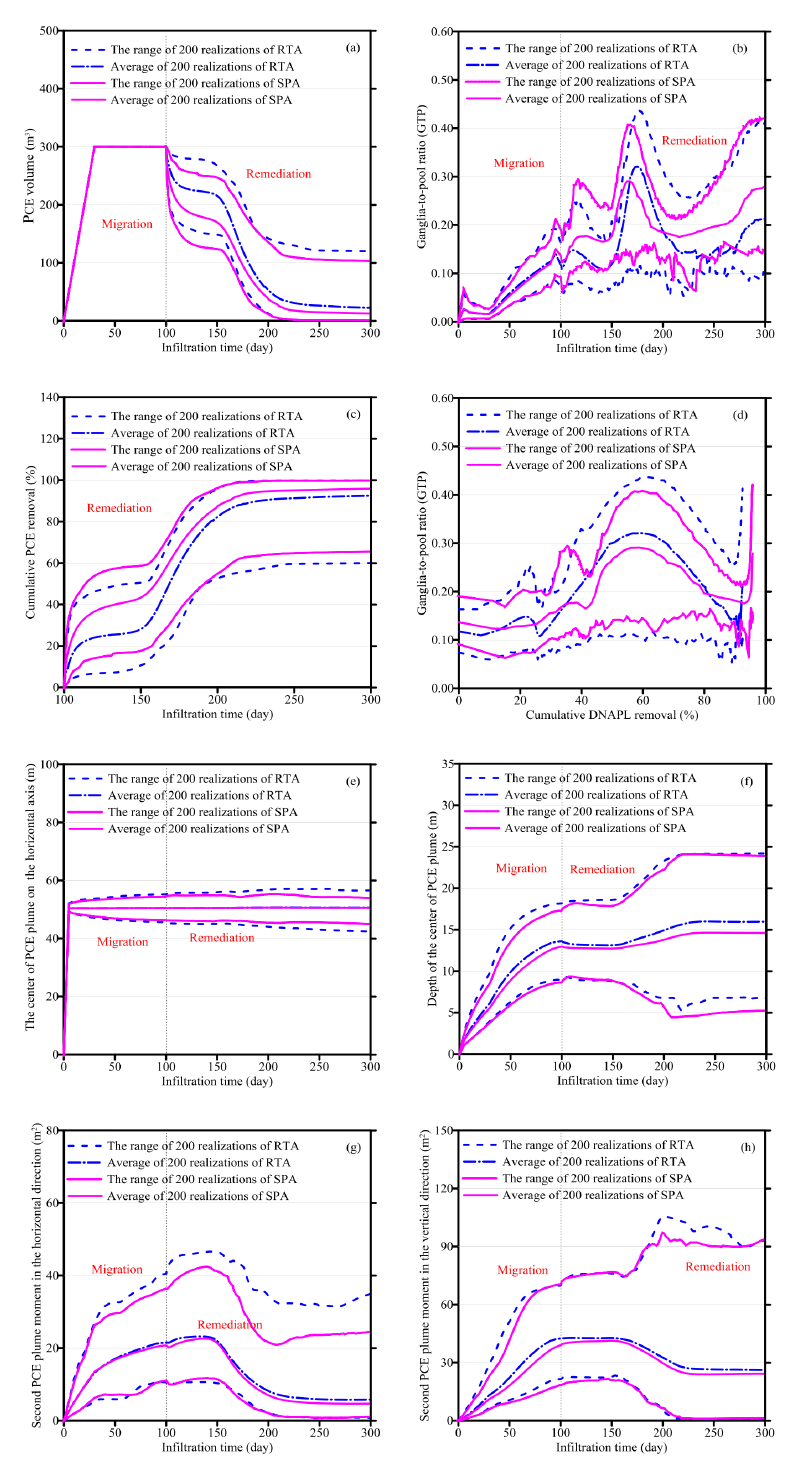
Figure 7. (a) PCE volume in aquifer vs. time, RTA represents RTA and SPA represents SPA; (b) changes in GTP as a function of time; (c) cumulative DNAPL removal as a function of time; (d) variation of GTP value as a function of cumulative DNAPL removal percent; (e) the change of the center of PCE plume during the entire periods of migration and remediation; (f) the change of the depth of PCE plume center during the entire periods; (g) variation of second PCE plume moment on the horizontal axis; and (h) variation of second PCE plume moment in vertical